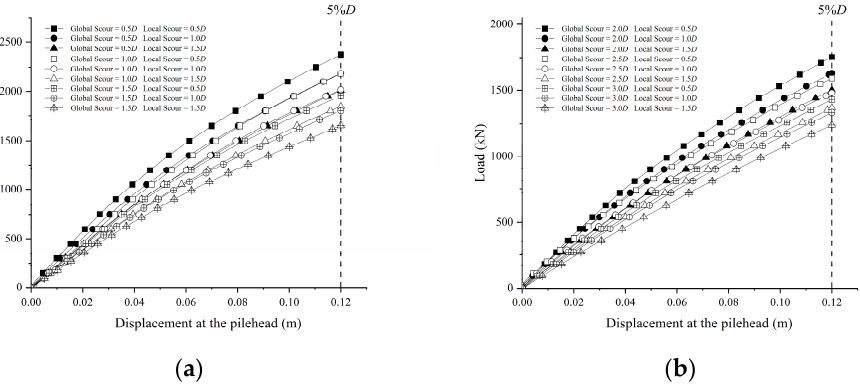
Figure 10. Combination scour effects on loaddisplacement curves ( a ) global scour depth had a range from 0.5 D –1.5 D and ( b ) from 2.0 D –3.0 D.